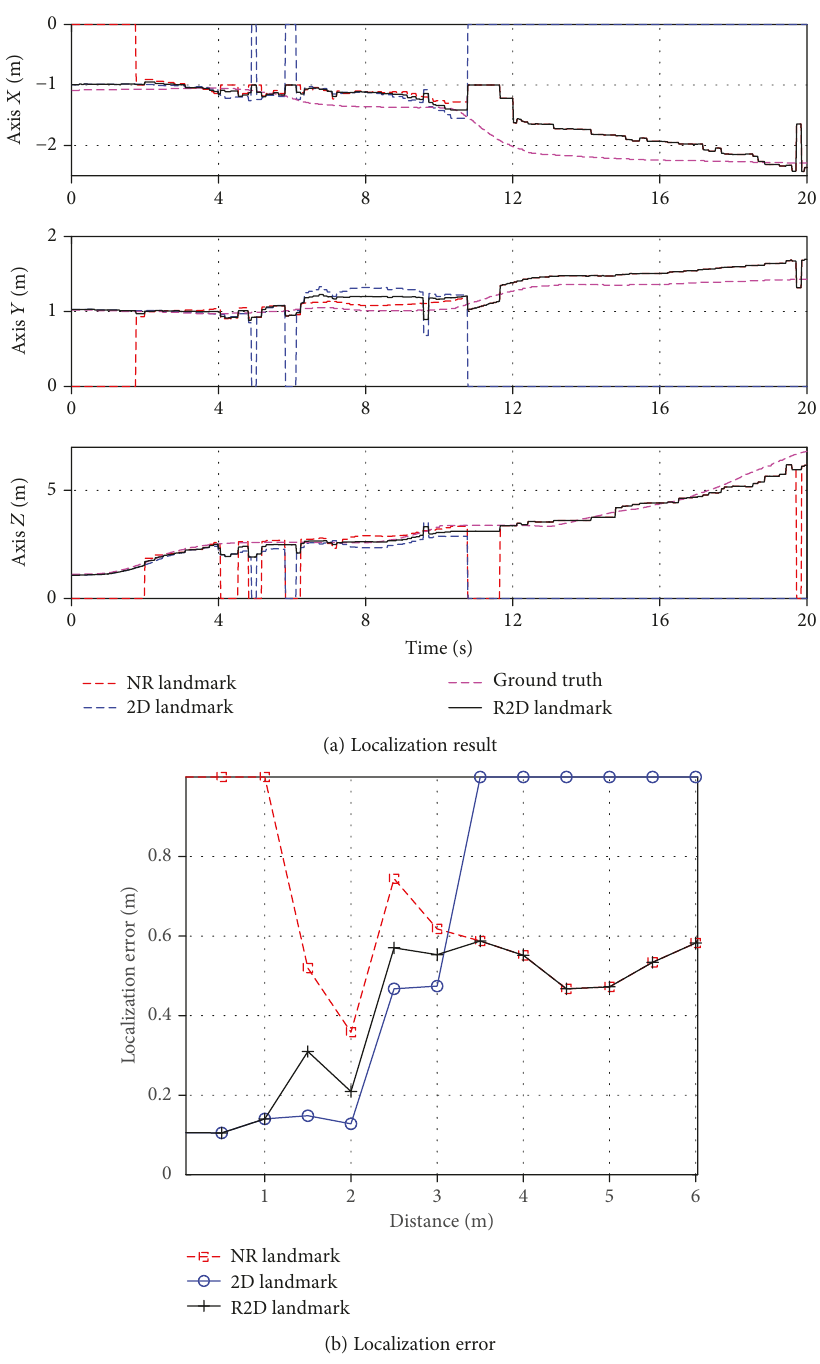
Figure 5: Localization results of the NR landmark, 2D landmark, and R2D landmark.